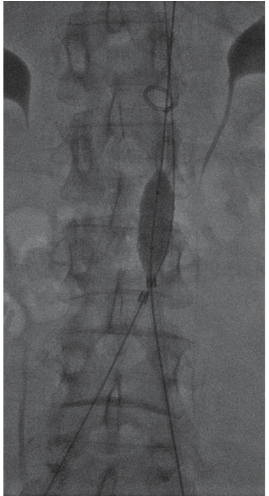
Figure 6: Deployment of the balloon expandable stent in the distal